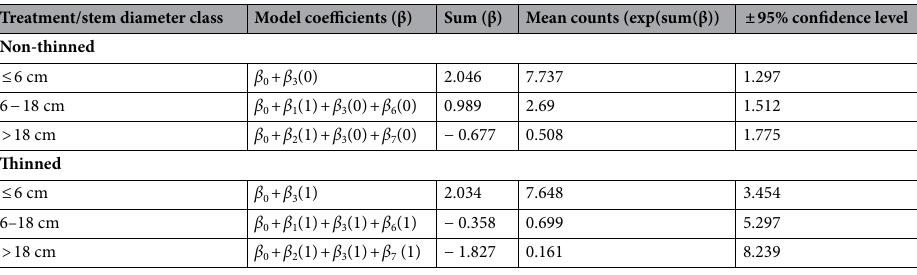
Table 7. Expected tree/shrub density per subplot (area: 113.1 m 2 ) in the non-thinned and thinned treatment areas estimated from the generalized linear mixed-effects model (GLMM) coefficients in stem classes, 0–6 cm., 6–18 cm. and ≥ 18 cm.